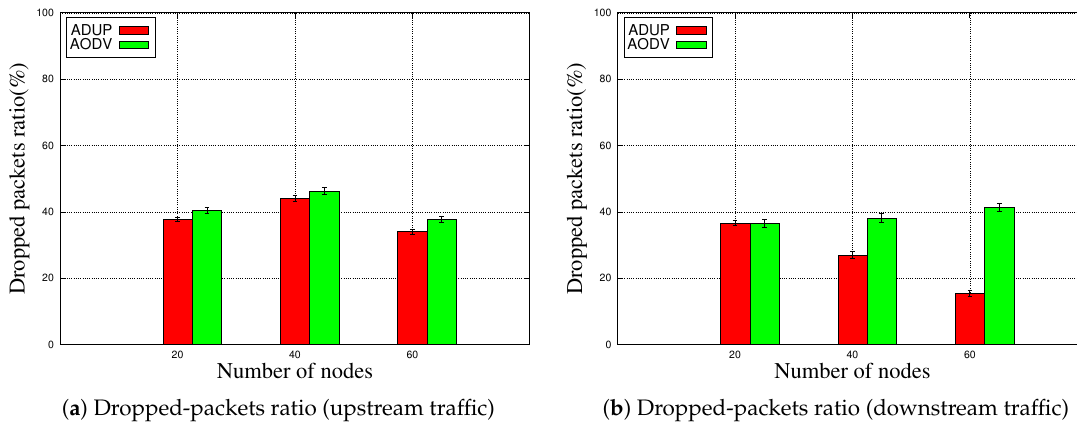
Figure 8. Dropped-packets